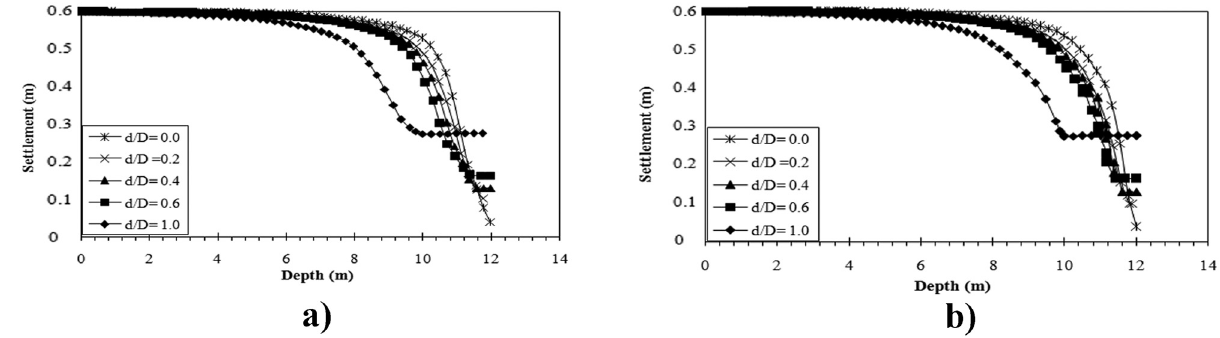
Figure 10: Settlement with depth after collapsing stage with di ff erent skirt ratio. ( a ) Below the center of footing. ( b ) Adjacent to the